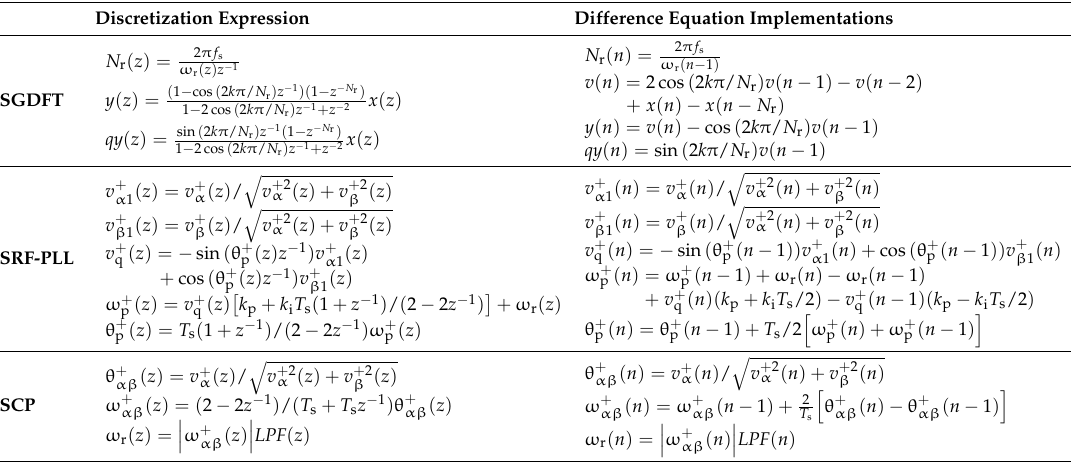
Table 1. The digital